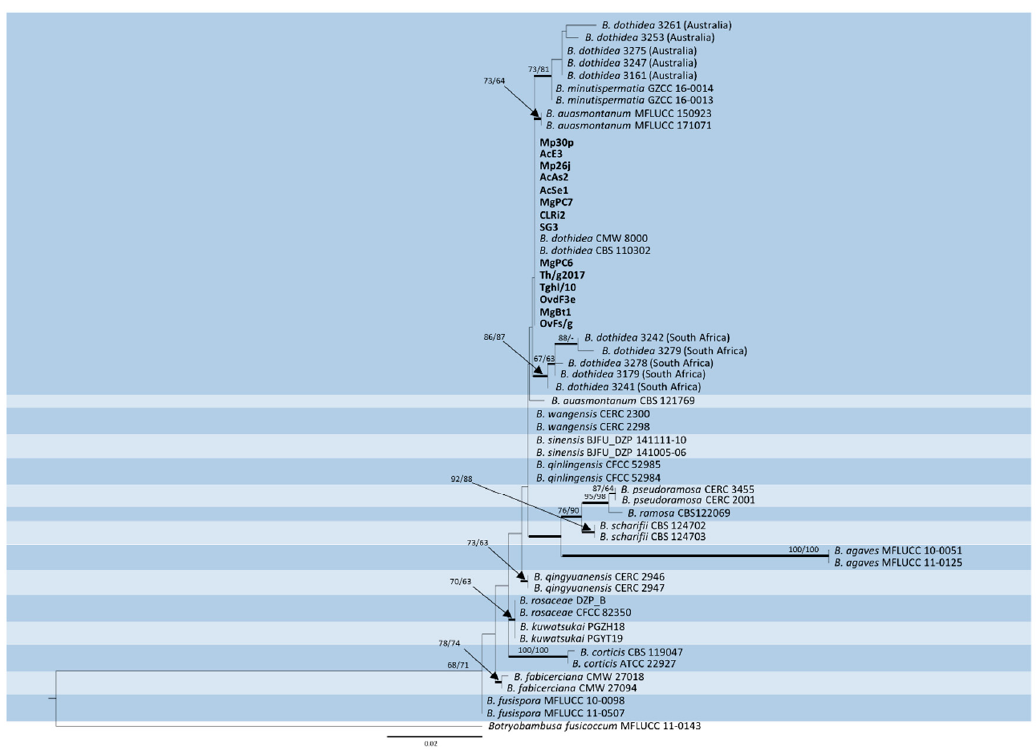
Figure 2. Phylogenetic tree based on maximum likelihood (ML) analyses of concatenated ITS and TEF1 sequences from strains considered in this study. Original isolates from Lamiaceae are in bold. Bootstrap support values ≥ 60% for ML and maximum parsimony (MP) are presented above branches as follows: ML/MP, bootstrap support values < 60% are marked with ‘-‘. Branches in bold are supported by Bayesian analysis (posterior probability ≥ 90%). Botryobambusa fusicoccum MFLUCC 11-0143 was used as the outgroup reference.